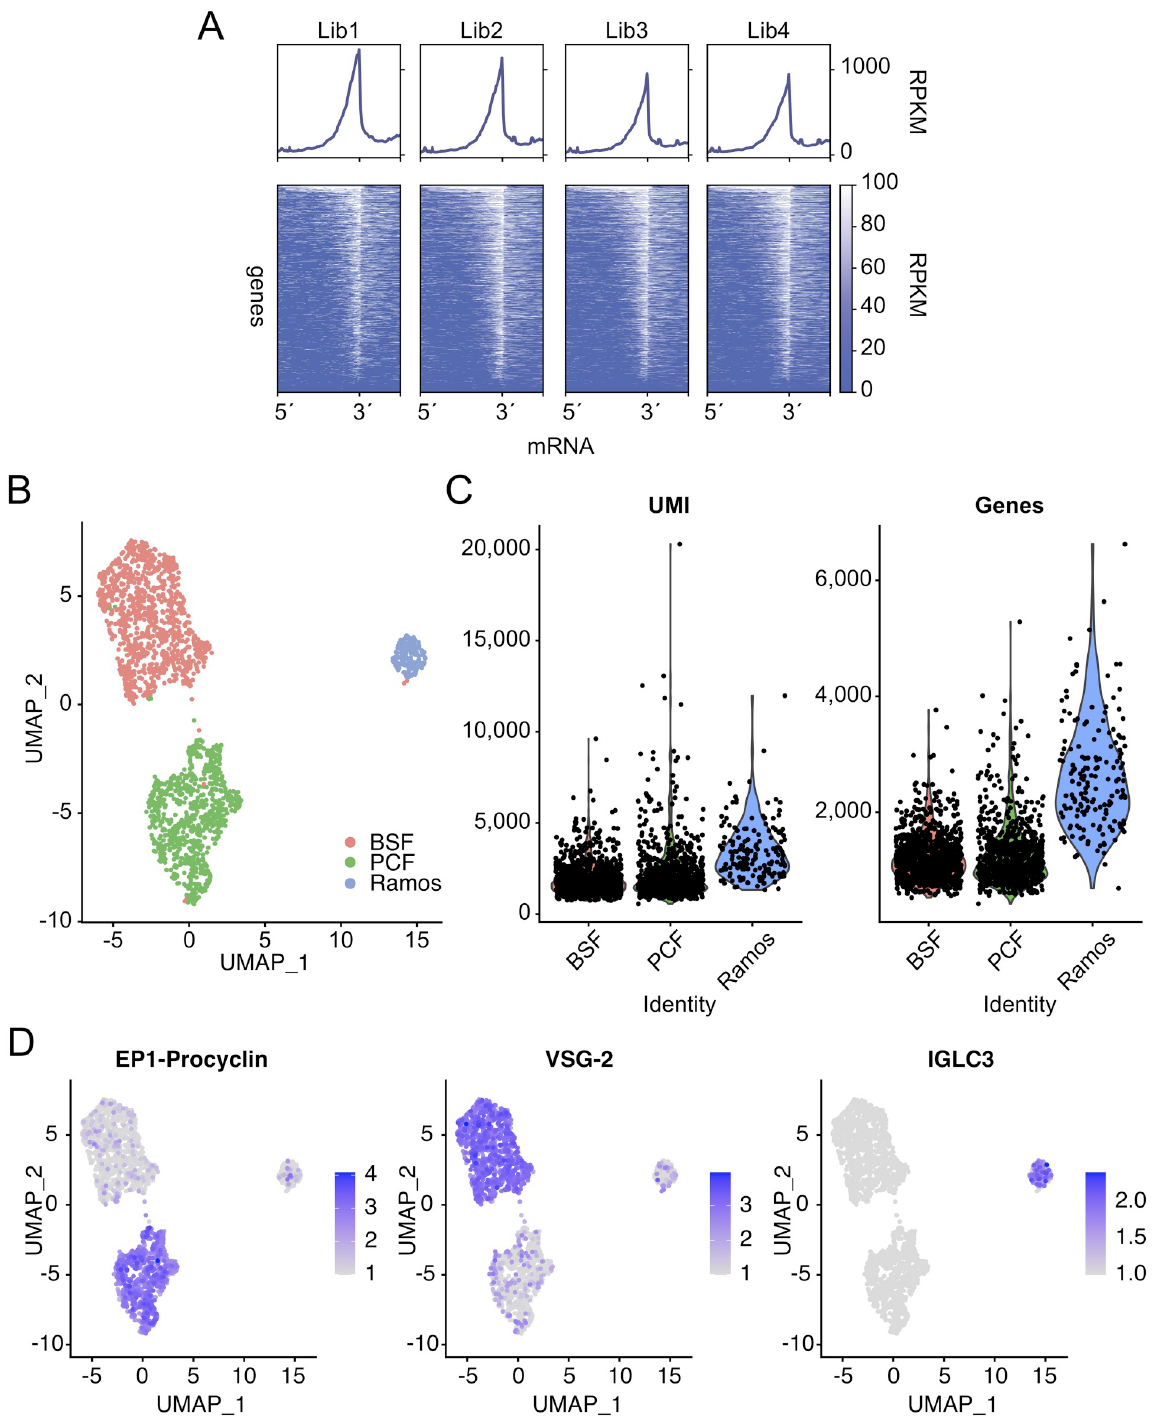
Fig 1. inDrop analysis of cultured bloodstream form and procyclic trypanosomes. A. inDrop performed in a microfluidic format, using a single primer to replace the BHMs (no single-cell resolution). The plots show the reads per kilobase per million mapped (RPKM) for annotated T . brucei transcripts aligned from their 5´splice site to the 3´polyadenylation sequence. Profile plots (above) show the average RPKM across the ~7,500 non-redundant gene set for trypanosomes. Heatmaps (below) show the RPKM for individual transcripts. C. UMAP projection of single- cell barcoding data for a population of cells containing calculated proportions of 47.5% for each BSF and PCF, and 5% Ramos cells. Measured cell proportions are 51% BSF, 41% PCF and 8% Ramos. D. Violin plots depict the total number of UMIs and genes captured per cell within BSF, PCF and Ramos cell clusters. E. UMAP projections from C overlaid with colour scale of gene expression values for EP1 procyclin (Tb927.10.10260), VSG-2 (Tb427.BES40.22) and Immunoglobulin lambda constant 3 (IGLC3).